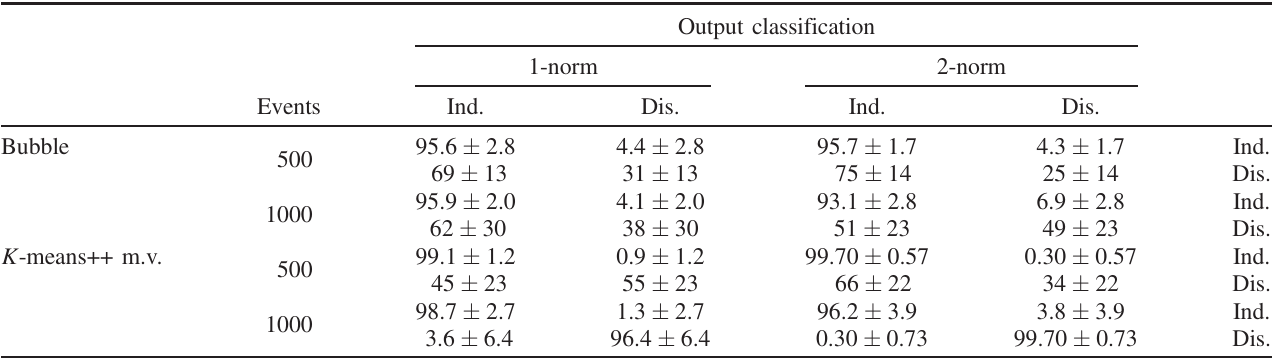
TABLE III. Confusion matrix for bubble clustering and K means++ with majority voting random unitary evolution [cross-validation stage, step (ii.a)]. Success percentages of the compatibility test for bubble clustering and K means initialized with K means++ and majority voting. These percentages are evaluated through numerical simulations, by drawing 20 Haar-random unitary transformations, and by adopting the same hyperparameters obtained from stage (i) corresponding to the results in Table II.